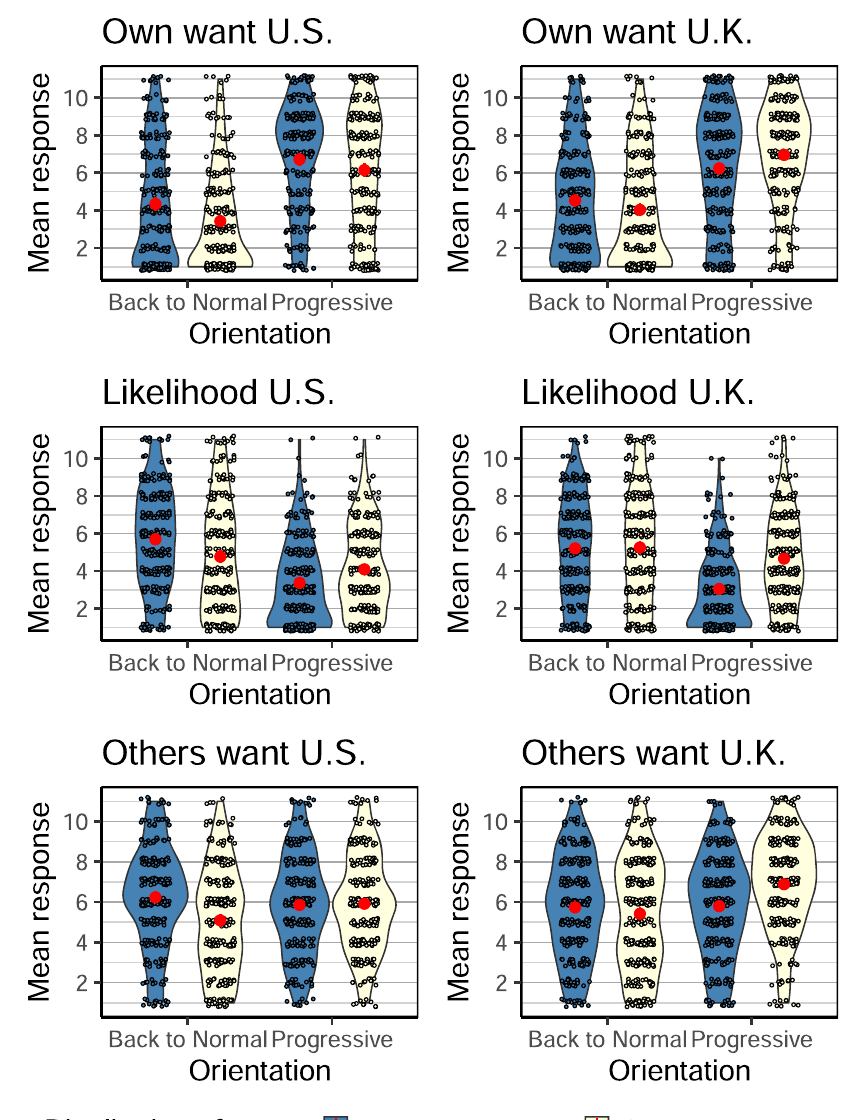
Fig. 3 Responses to three main questions in Experiment 1. Panels on the left show responses from the US, and panels on the right from the UK. The top row reports people ’ s own preferences, the center row reports likelihood, and the bottom row perceptions of what others want. In each panel, the red plotting symbols and error bars represent means and 95% con fi dence intervals. Data are jittered to avoid overprinting. See text for